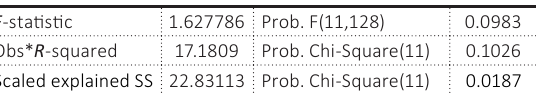
Table 5. Test for heteroskedasticity